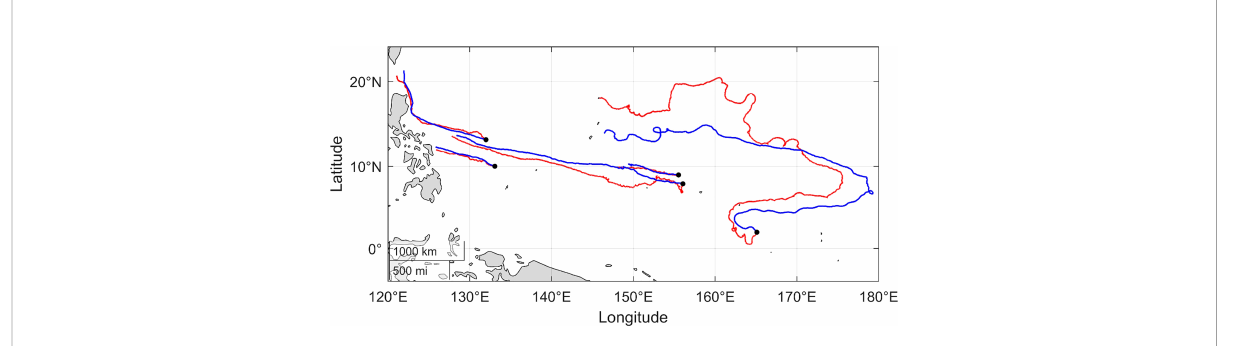
FIGURE 5 The trajectory of (red line) drifters and (blue line) LPTM results. The black dots denote the initial locations.